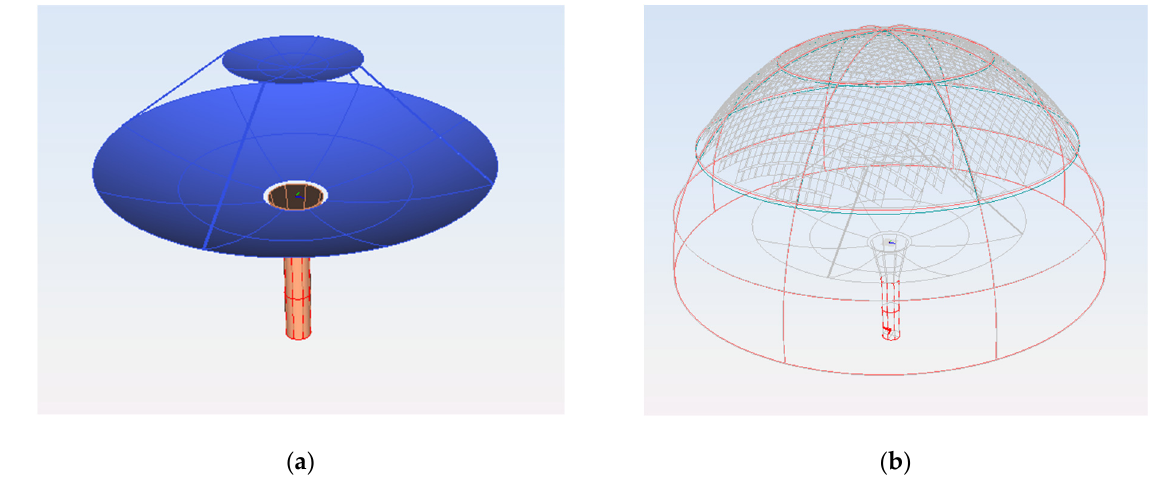
Figure 4. Geometrical model of ( a ) antenna, containing a conical horn and a Cassegrain Reflector; ( b ) the full scenario, containing the antenna covered by a hemispherical dome built using a two-layered radome with a cross-shaped FSS embedded within the inner interface at the top, and a single layer radome at the